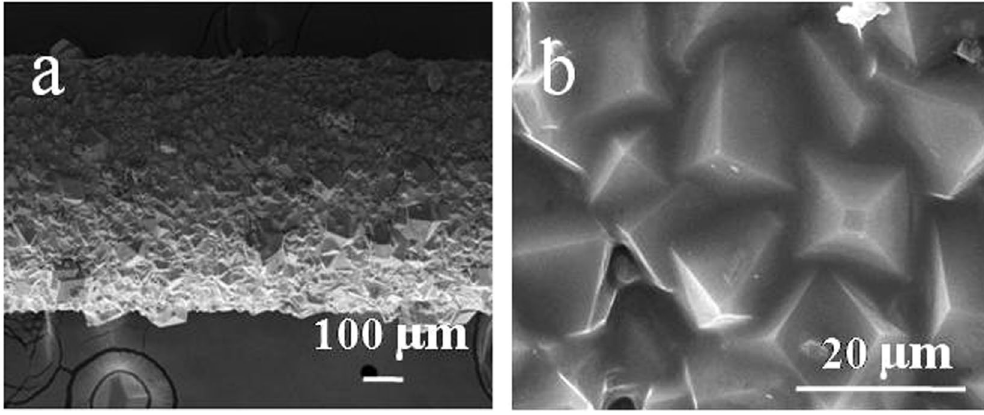
Figure 2. SEM images of ZIF-8 membrane grown on IL-modified pencil bar. ( a ) low magnification, ( b ) high magnification.